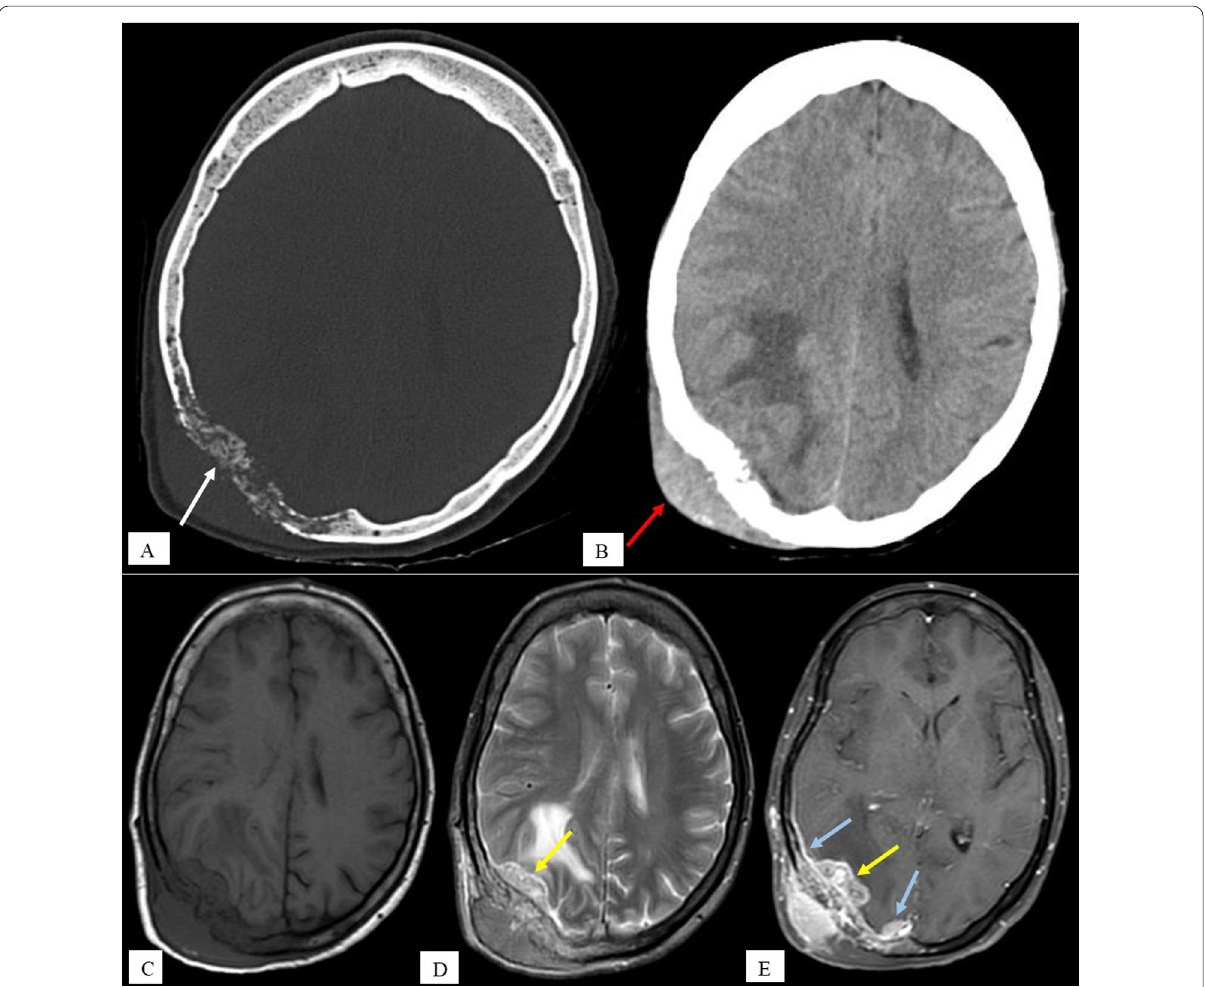
Fig. 4 Evaluation of dural involvement in a 51 year old lady with skull metastases from carcinoma breast- CT bone window ( A ) and soft tissue window ( B ) images show a large mixed (lytic sclerotic) lesion (white arrow) in right parieto-occipital region with associated heterogeneous soft + tissue mass (red arrow). No obvious dural involvement can be seen on CT. MRI T1W ( C ), T2W ( D ) and post contrast T1W ( E ) images clearly show enhancing adjacent dural thickening (yellow arrows) with dural tail sign (blue